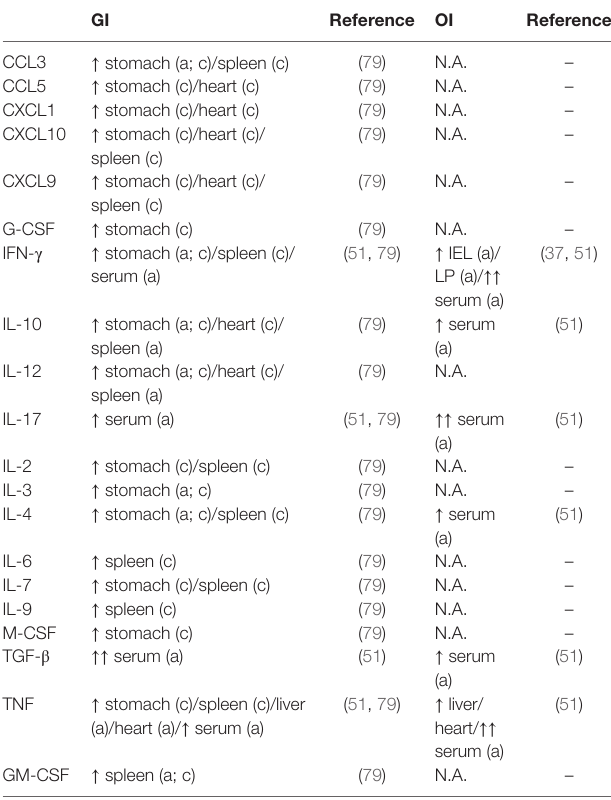
TABLe 1 | Cytokines are differentially expressed according to the infection route. Gi Reference Oi